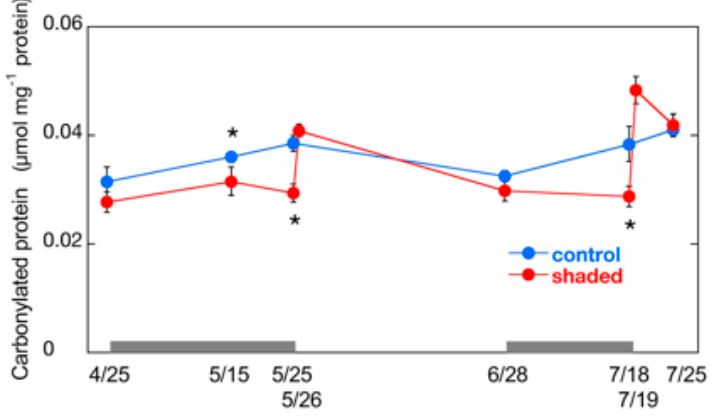
Figure 3. Changes in carbonylated protein content in shaded tea leaves after shade removal. Gray bars indicate the period of shading treatments. Data are shown as means ± standard deviation ( n = 3). Statistical analysis was performed by pairwise comparison of control and shaded plants by t -test. The data 1 day after shade removal in the shaded plants were compared with those at day 0 in the control. Asterisks indicate significant differences ( p <